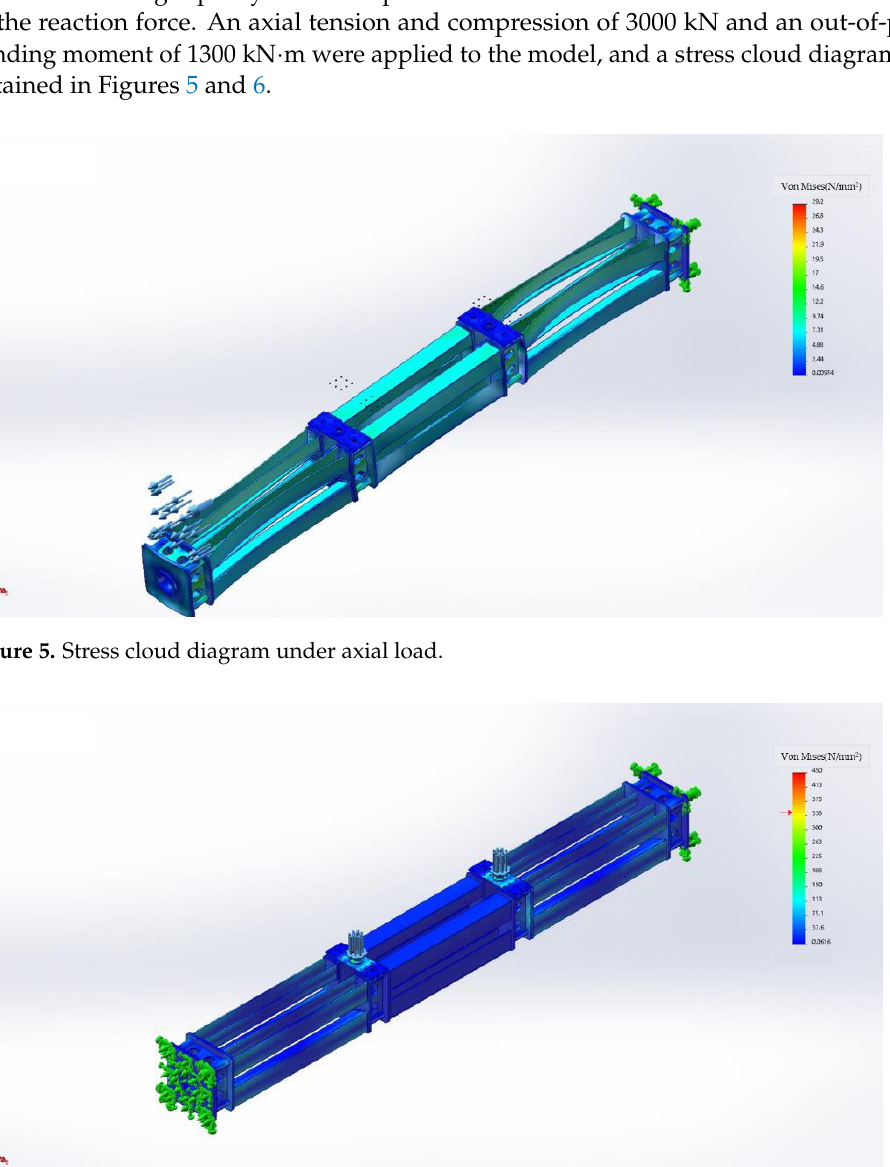
Figure 4. Connection form of the middle frame joint.